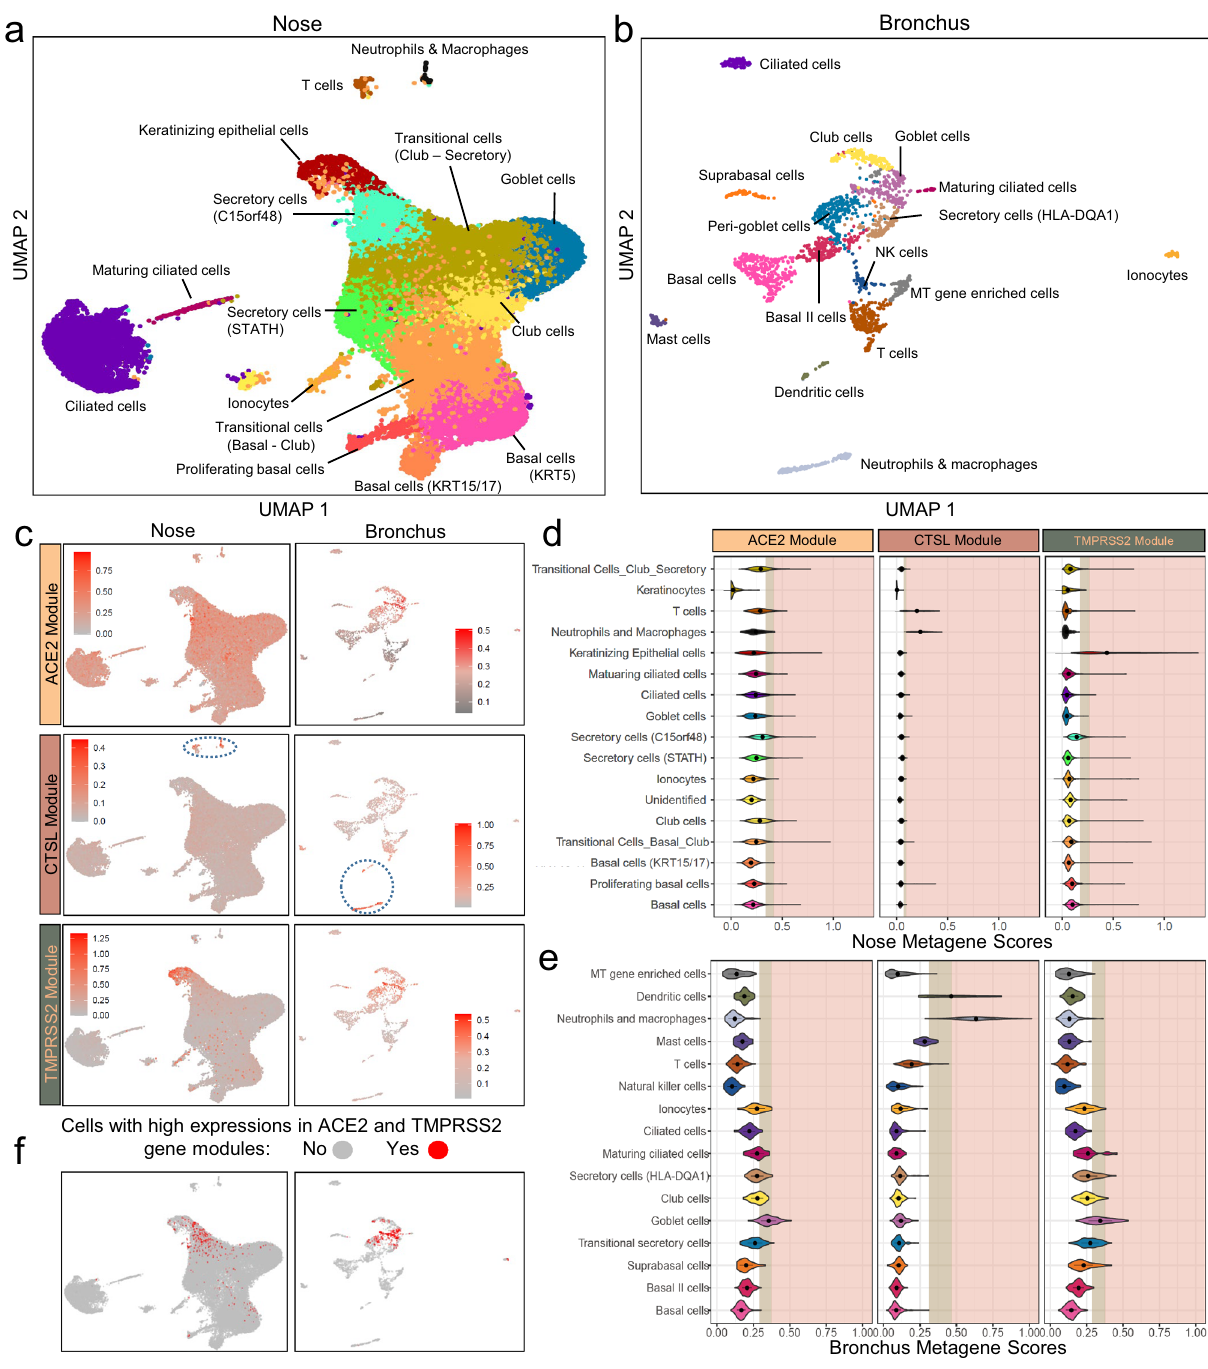
Figure 3. Comparison of expression patterns for VE gene modules across cell types from nasal and bronchial brushings. Single-cell RNA-seq was performed ( a ) on nasal brushings from 7 patients (n = 34,833 cells) and ( b ) bronchial brushings from 17 patients (n = 2,075 cells). Cell types were inferred from the expression of known marker genes. (c) UMAP projections showing the expression pattern of VE gene modules (ACE2, top; CTSL, middle; TMPRSS2 bottom) across different cell types in the nasal (left) and bronchial (right) epithelium. The cells are colored gray for low expression and red for high expression of metagene scores of each VE gene module. Immune cells with high expression of the CTSL modules were encircled in blue ( d–e ). Violin plot showing the metagene score for each VE gene module across the cell types in ( d ) nasal and ( e ) bronchial epithelium . For each violin plot, metagene expression is designated as elevated (light brown) or highly elevated (pink) if it is greater than one or two standard deviations above the mean metagene score, respectively. ( f ) UMAP projections showing cells greater than 1 standard deviation above the mean for both ACE2 and TMPRSS2 modules (i.e., double-positive). Double positive cells were enriched in nasal secretory (C15orf48 +) and keratinizing epithelial cells (left) and bronchial goblet cells